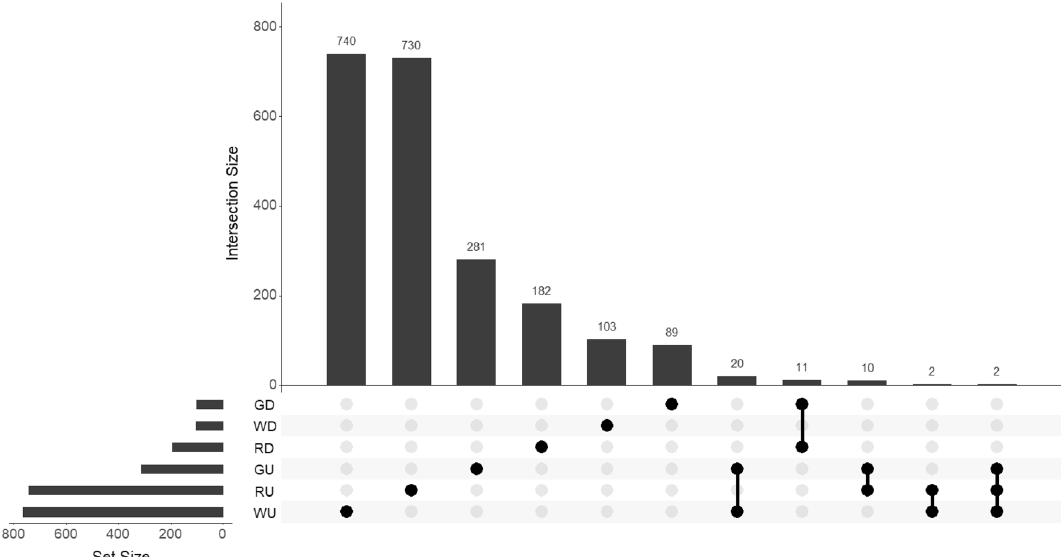
Figure 1. Intersections of the results from the eQTL analysis, showing unique and common cis -eQTLs in down regulated genes in white cultivars (WD), up regulated genes in white cultivars (WU), down regulated genes in red cultivars (RD), up regulated genes in red cultivars (RU), down regulated genes after the general analysis (GD) and up regulated genes after the general analysis